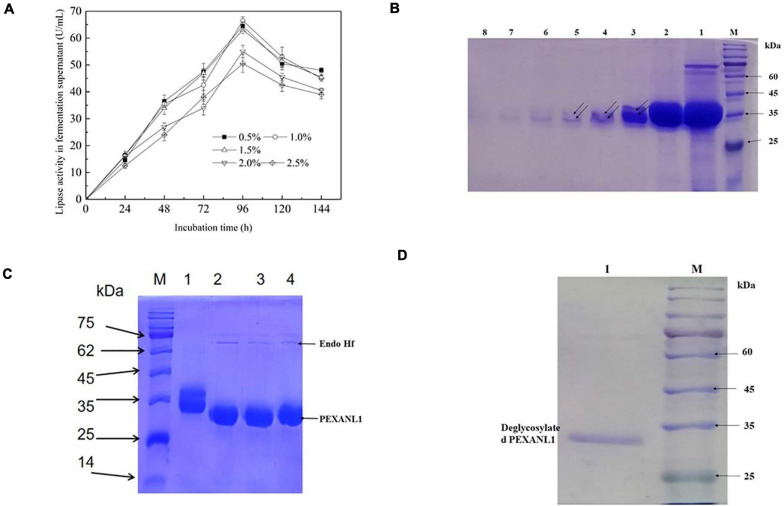
Optimal expression conditions and gel electrophoresis of purification process of PEXANL1. (A) The effect of methanol addition and induction time on PEXANL1 produced by Pichia pastoris GS115. The enzyme activity of the yeast-induced fermentation supernatant was measured periodically. (B) SDS-PAGE analysis of PEXANL1 purified by a Ni-NTA column. Lane M: The molecular weight marker. Lane 1: Crude enzyme ultrafiltration concentrate; lanes 2–8: 3 mL of buffer A elution collection solution containing 250 mM imidazole, corresponding to 1–7 tubes, the double arrow pointed to the two molecular weights of PEXANL1 due to the difference in sugar content. (C) SDS-PAGE analysis of deglycosylation of purified PEXANL1. Lane M: The molecular weight marker. Lane 1: Purified PEXANL1; lanes 2–4: purified PEXANL1 treated with Endo Hf. (D) SDS-PAGE analysis of removal of Endo Hf by a amylose resin column. Lane M: the molecular weight marker. Lane 1: deglycosylated purified PEXANL1 showing a single band around 35 kDa.